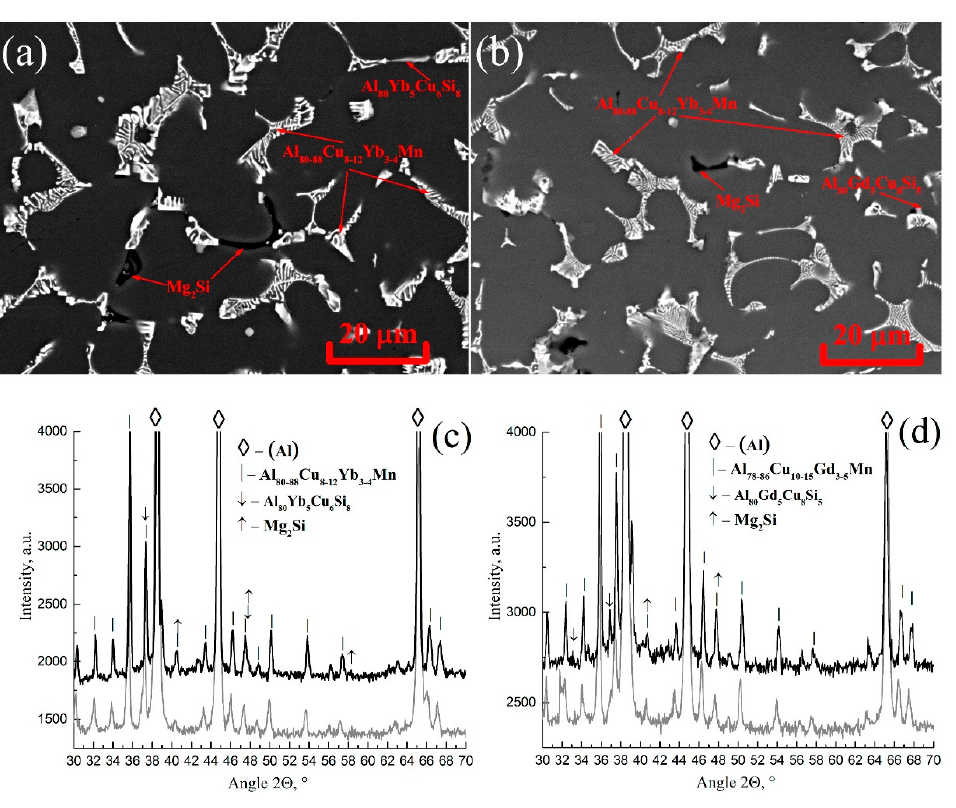
Figure 2. As-cast microstructure and phase composition of the ( a , c ) AlCuYbMg and ( b , d ) AlCuGdMg alloys (( a , b )—SEM-BSE phase composition, ( c , d )—XRD (grey lines—Mg-,Si- and Fe-free alloys)). Table 2. As-cast composition of the Al solid solution .